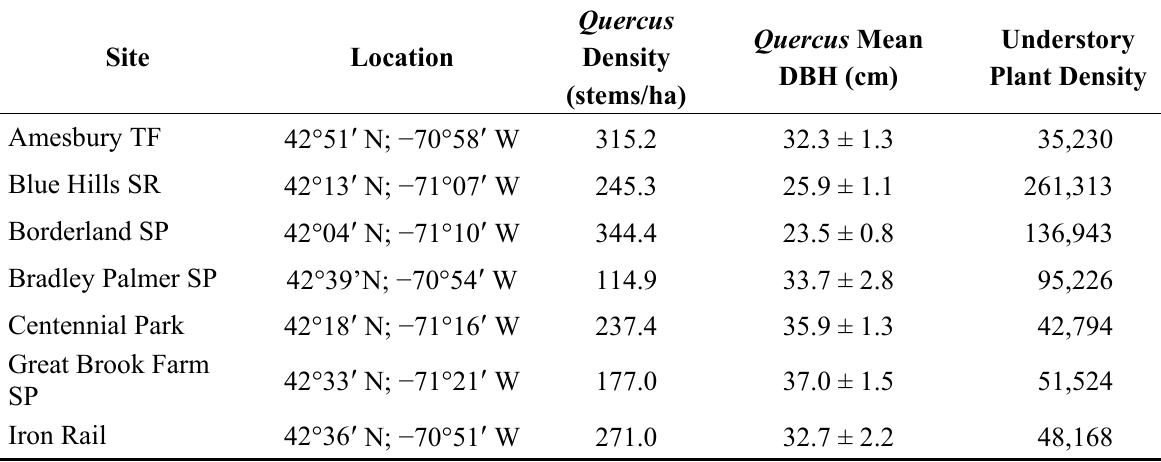
Table 1. Name, location, Quercus density and quadratic mean diameter (DBH),